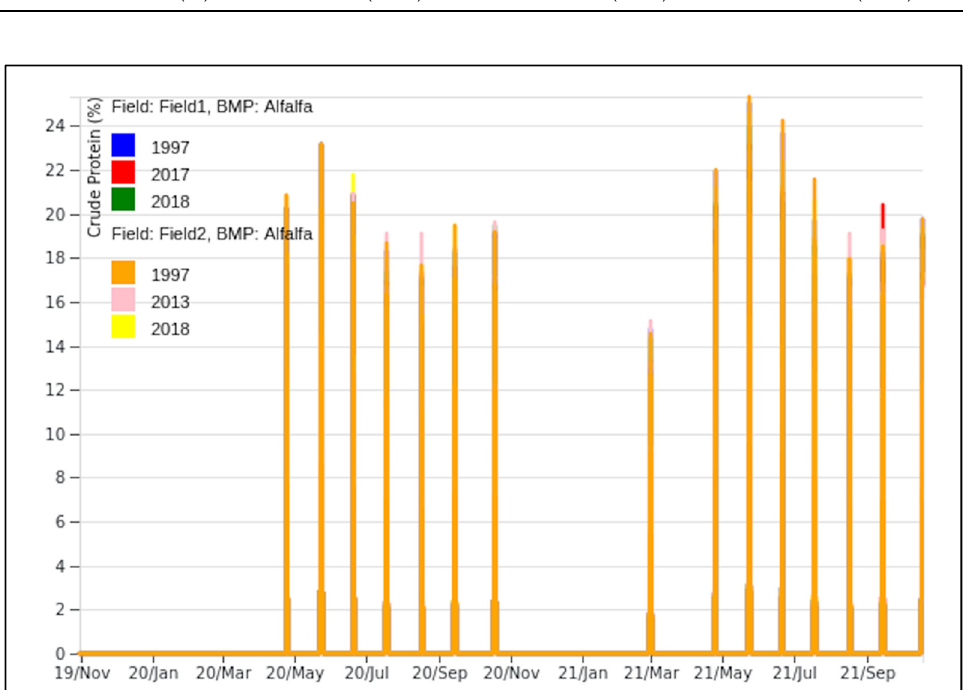
Figure 8. Water Productivity for Field 1 (near Tulare, California) and Field 2 (near Davis, California).